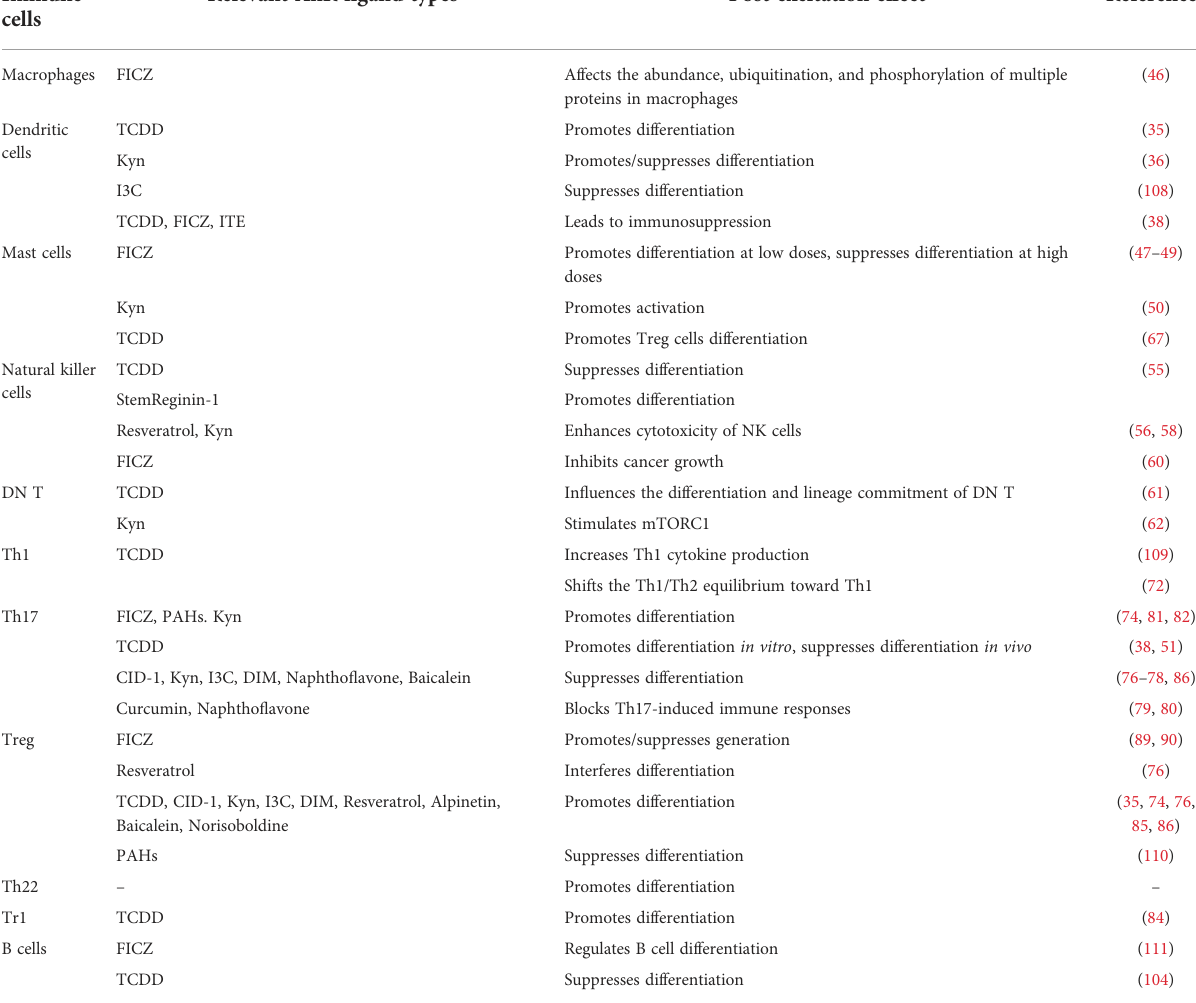
TABLE 2 Effect of AhR ligand activation on immune